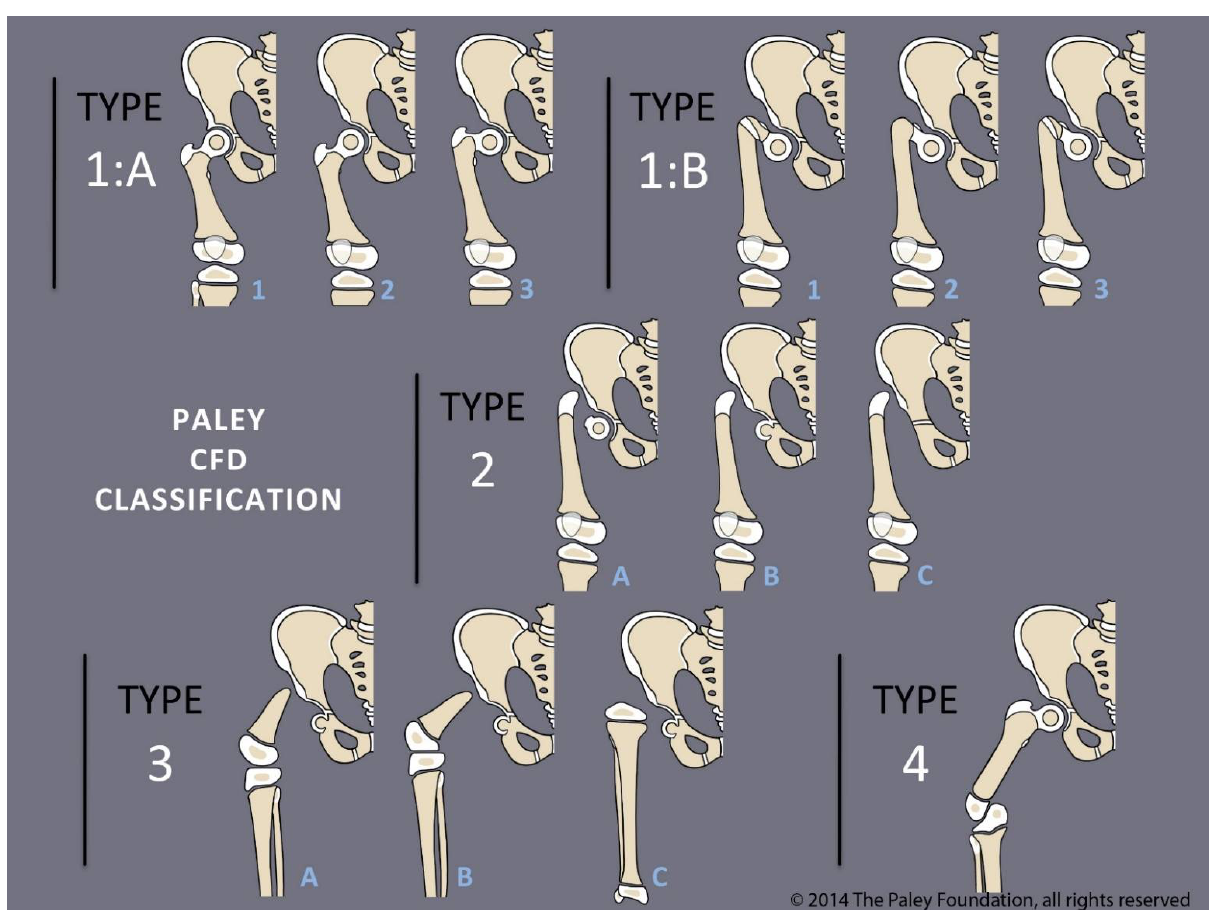
Figure 1. Paley CFD classification.